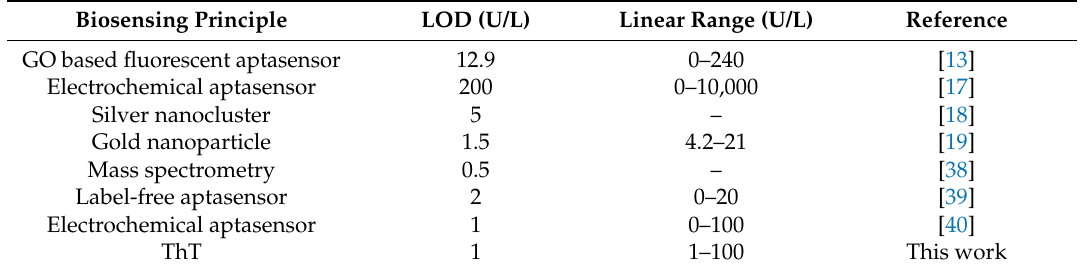
Table 1. Comparison with the currently reported methods for ADA determination.